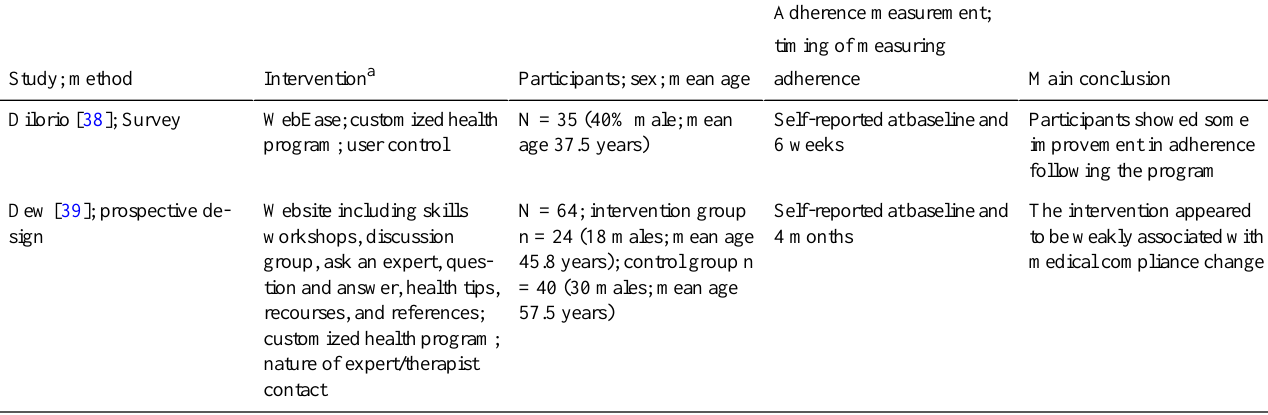
a Sophistication of tailoring classification based on Figure 2. b Randomized controlled trial.